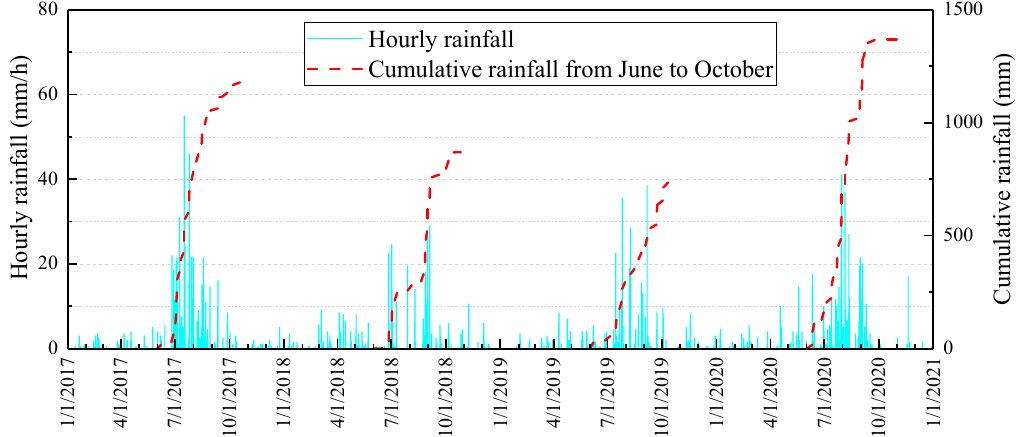
Figure 7. Precipitation recorded during the four years (2017–2020) at the Songnisan landslide monitoring station.